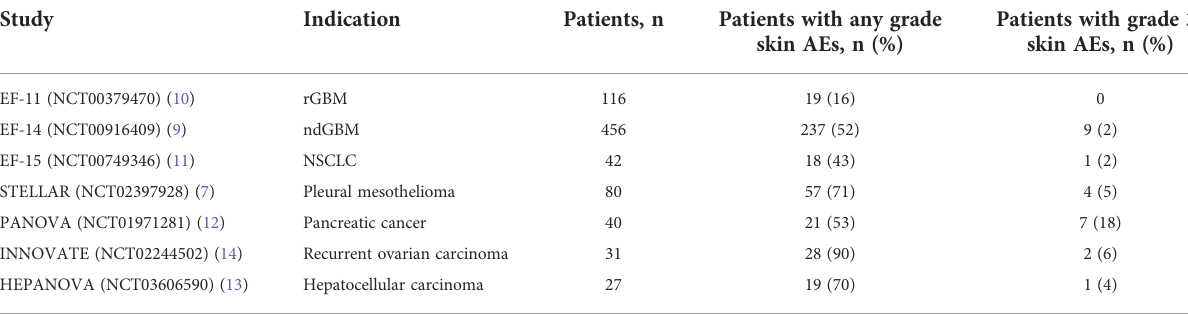
TABLE 1 Overview of skin AEs from pivotal TTFields therapy clinical studies. Study Indication Patients, n Patients with any grade